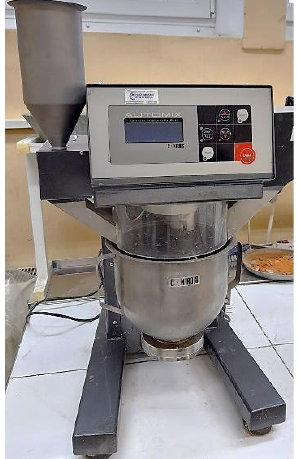
Figure 1. Automatic programmable mixer 65-L0006/AM. Table 4. Parameters of the preparation of the cement mixtures.